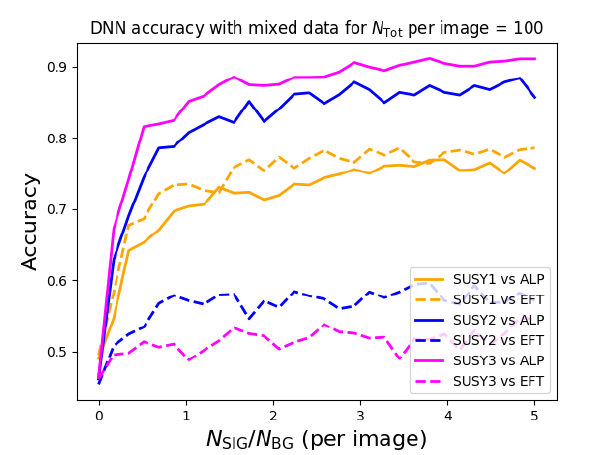
Figure A6: DNN for 2D histogram accuracy for differing number of signal events for trained for 100